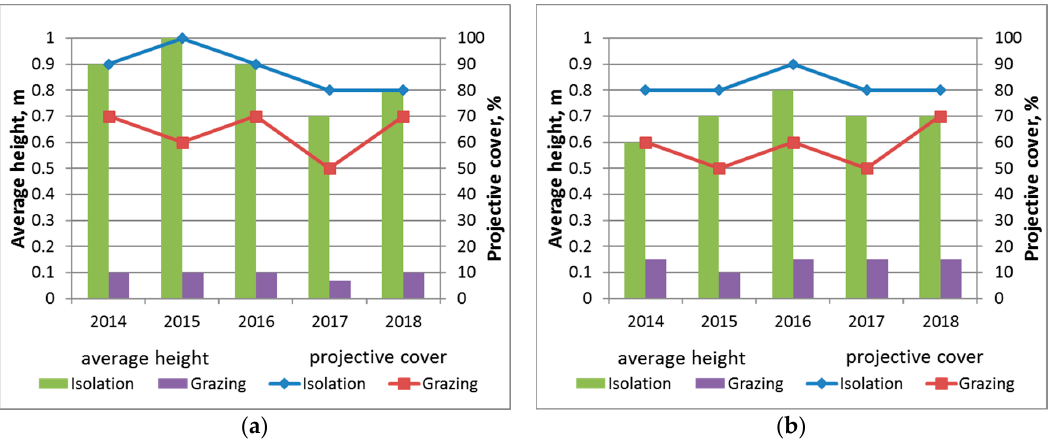
Figure 5. Changes in the structure of the community in the upper (a) and middle (b) zones. Table 1. Dynamics of the species composition of the community of the upper zone. Years of Succession Indicator Before Isolation